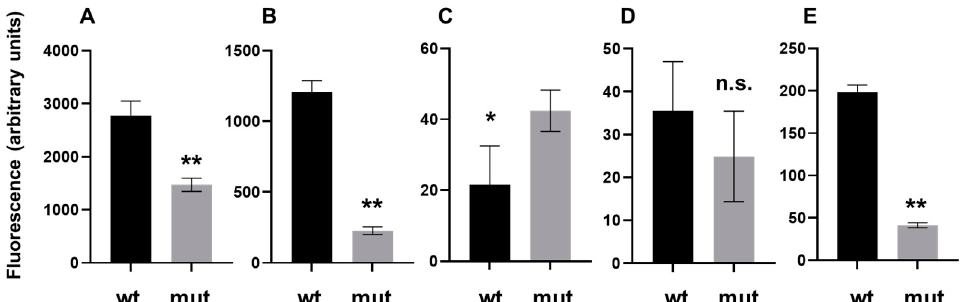
Figure 3. Expression of GFP reporter gene bearing putative GCGC-containing promoters in H. pylori G27 wild type and mutant lacking M.HpyGIII. ( A ) GFP reporter gene containing the H. pylori G27 icdA promoter; ( B ) GFP reporter gene containing the H. pylori G27 hpg27_846 promoter; ( C ) GFP reporter gene containing the H. pylori G27 cah promoter; ( D ) GFP reporter gene containing a predicted antisense promoter within H. pylori G27 hpg27_865 ; ( E ) GFP reporter gene containing H. pylori J99 jhp0160 . Mean values for GFP fluorescence in wild-type H. pylori G27 are indicated by black bars, while mean values for GFP fluorescence in the H. pylori G27 mutant lacking M.HpyGIII are shown in gray bars. Six to twelve replicates were prepared for each condition. Error bars indicate 95% confidence intervals. Statistical analysis of the data was performed using an unpaired t -test with GraphPad Prism 9.0.2. Asterisks indicate differences in GFP fluorescence that were significant (**, p -value < 0.0001; *, p -value = 0.0014).